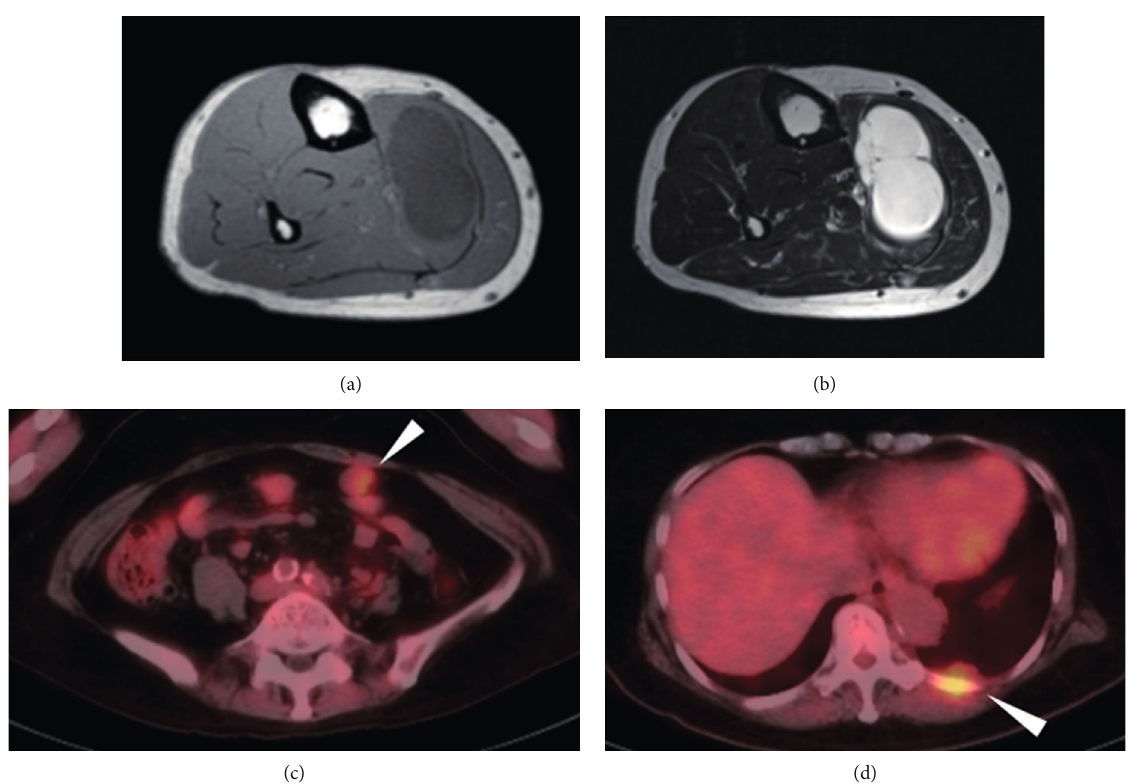
Figure 3: Metastatic tumors in the lower right leg, abdominal space, and chest wall. (a) T1-weighted and (b) T2-weighted MRI showing metastatic tumor in the lower right leg. Metastasis in (c) abdominal space and (d) chest wall in